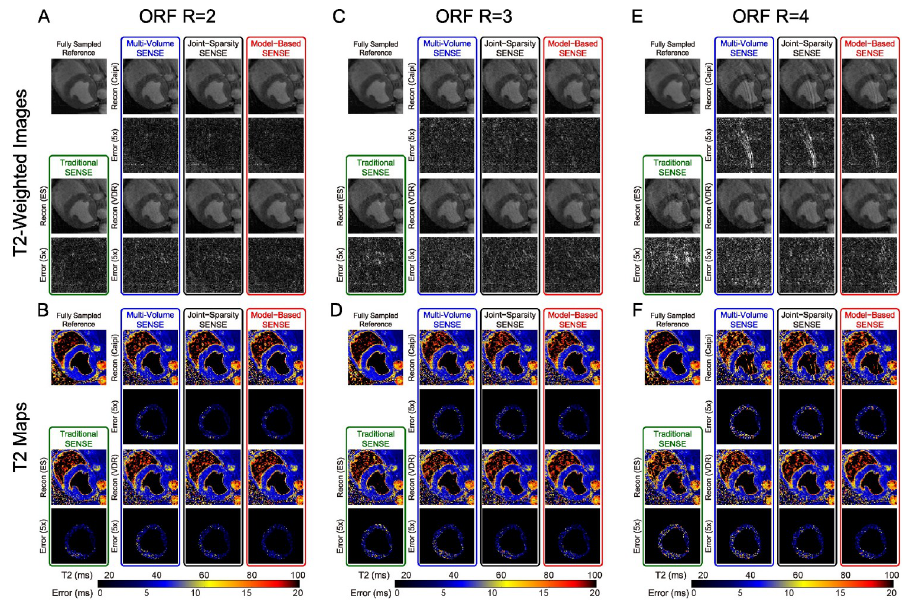
Fig 3. T2-weighted images and T2 maps from a naive swine with ORF = 2–4 and all reconstruction approaches. T2-Prep TE is 45 ms in the T2-weighted images. Errors maps are multiplied by 5 for increased visibility and T2 map error maps are masked with the segmented left ventricular ROI. As ORF increases (left to right), traditional volume- by-volume SENSE reconstruction begins to fail. At ORF = 4, images based on Caipi sampling pattern suffer from significant ghosting artifacts, which are reduced with VDR sampling (E), and T2 maps based on VDR sampling show lower T2 error (F). g-factor map based noise. Fig 3F shows that T2 maps based on VDR sampling pattern com- bined with model-based SENSE reconstruction have the lowest errors in the LV, especially in septal and posterior wall areas.